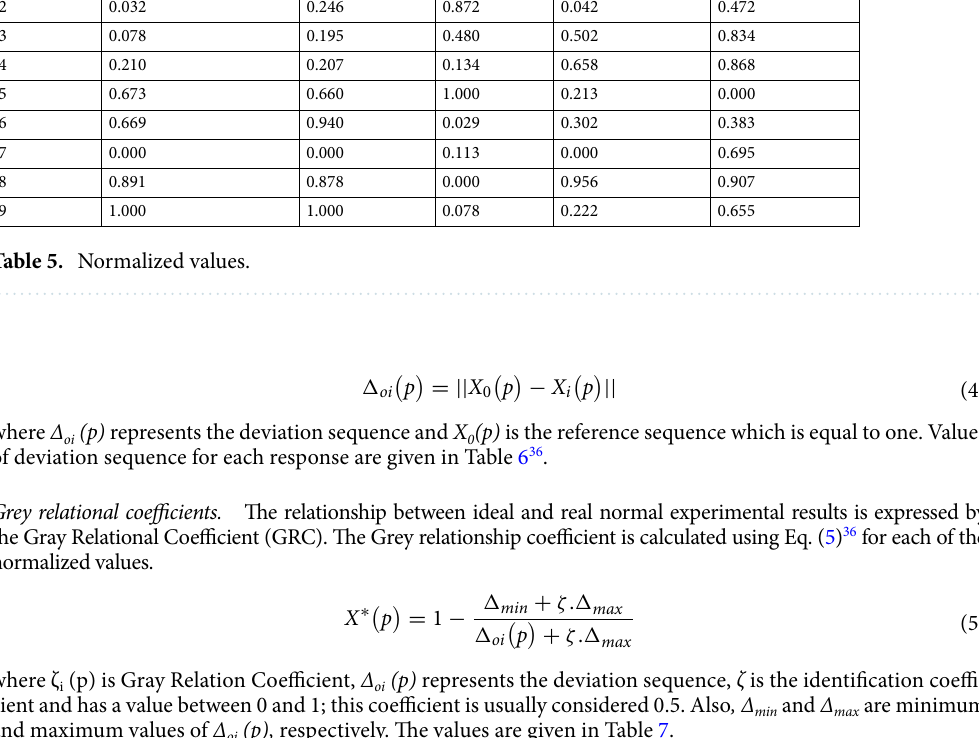
where ζ i (p) is Gray Relation Coefficient, ∆ oi (p) represents the deviation sequence, ζ is the identification coeffi- cient and has a value between 0 and 1; this coefficient is usually considered 0.5. Also , ∆ min and ∆ max are minimum and maximum values of ∆ oi (p), respectively. The values are given in Table 7. Gray relational grade. In general, the Gray Relational Grade (GRG) is used to evaluate the multi-response proper- ties. On the other hand, GRG is the average sum of the GRC, and Eq. (6) is used to determine it 36 .